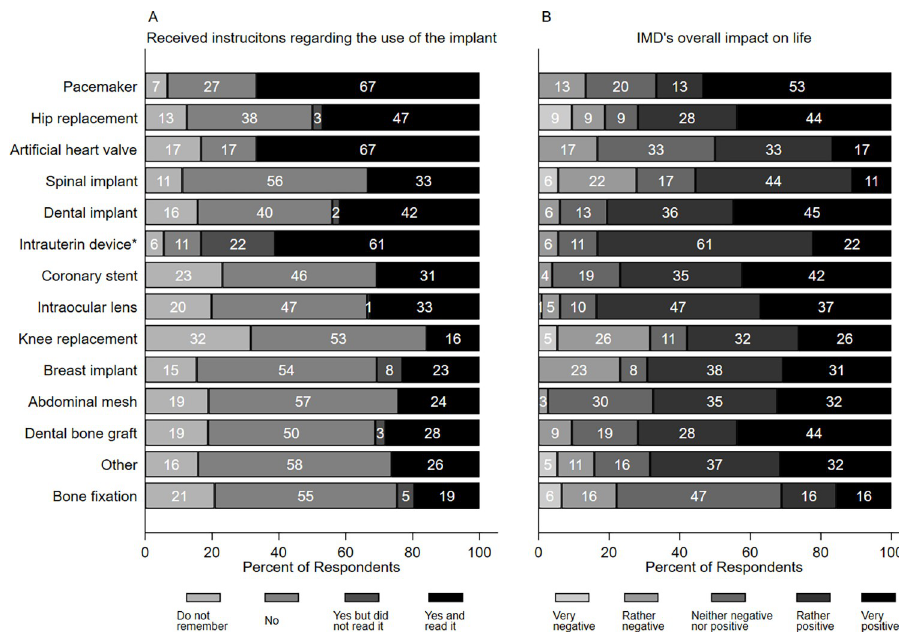
Fig 2. Share of responses on the received instructions for use for the IMD question and patients’ views about IMD’s overall impact on their life by IMD type (N = 433). * Only for women; Data for ‘glucose sensor’ are not presented as only one women case was